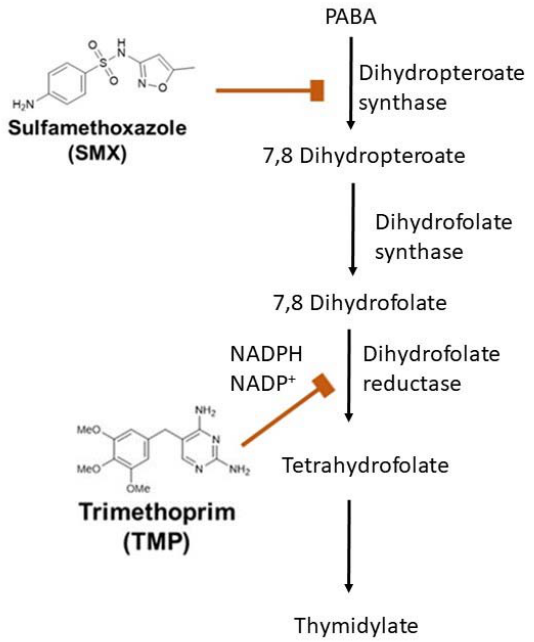
Figure 1. Folic acid biosynthesis pathway.